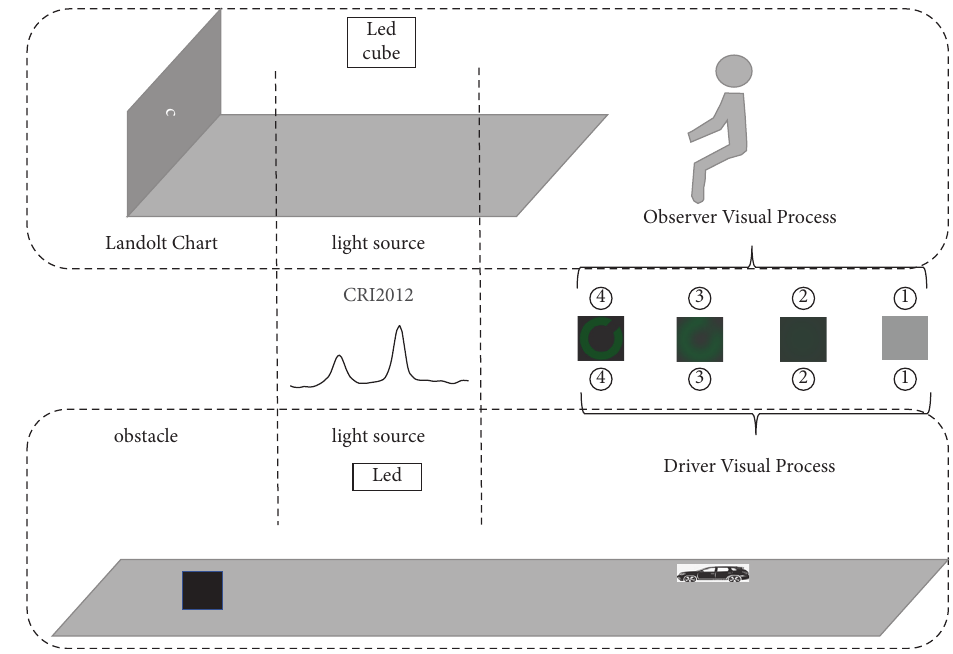
Figure 11: Comparison of the visual process in laboratory and visual process in real tunnels.